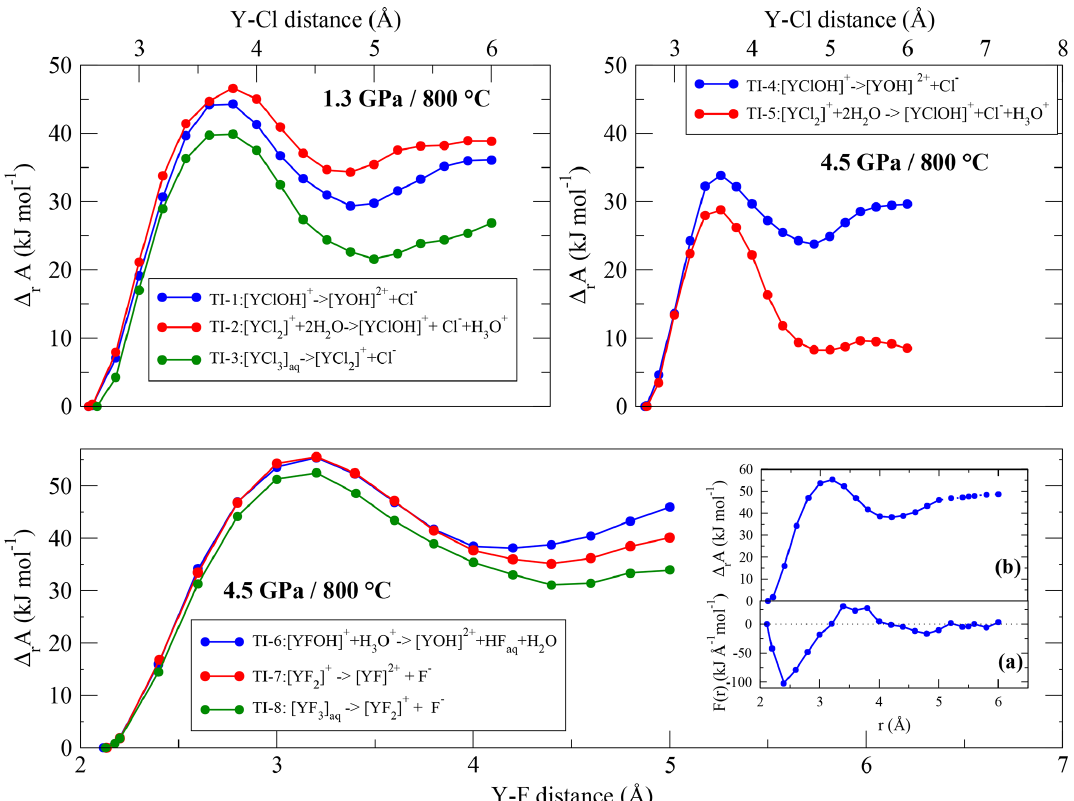
Figure 8. Evolution of the Helmholtz free energy derived from thermodynamic integration for Y − Cl / F complexes at 800 ◦ C and 1 . 3 / 4 . 5GPa Inset: (a) potential of mean force of the dissociation reaction of [ YFOH ] + to YOH + Helmholtz free energy along the integration pathway (for higher magnification, see Fig.